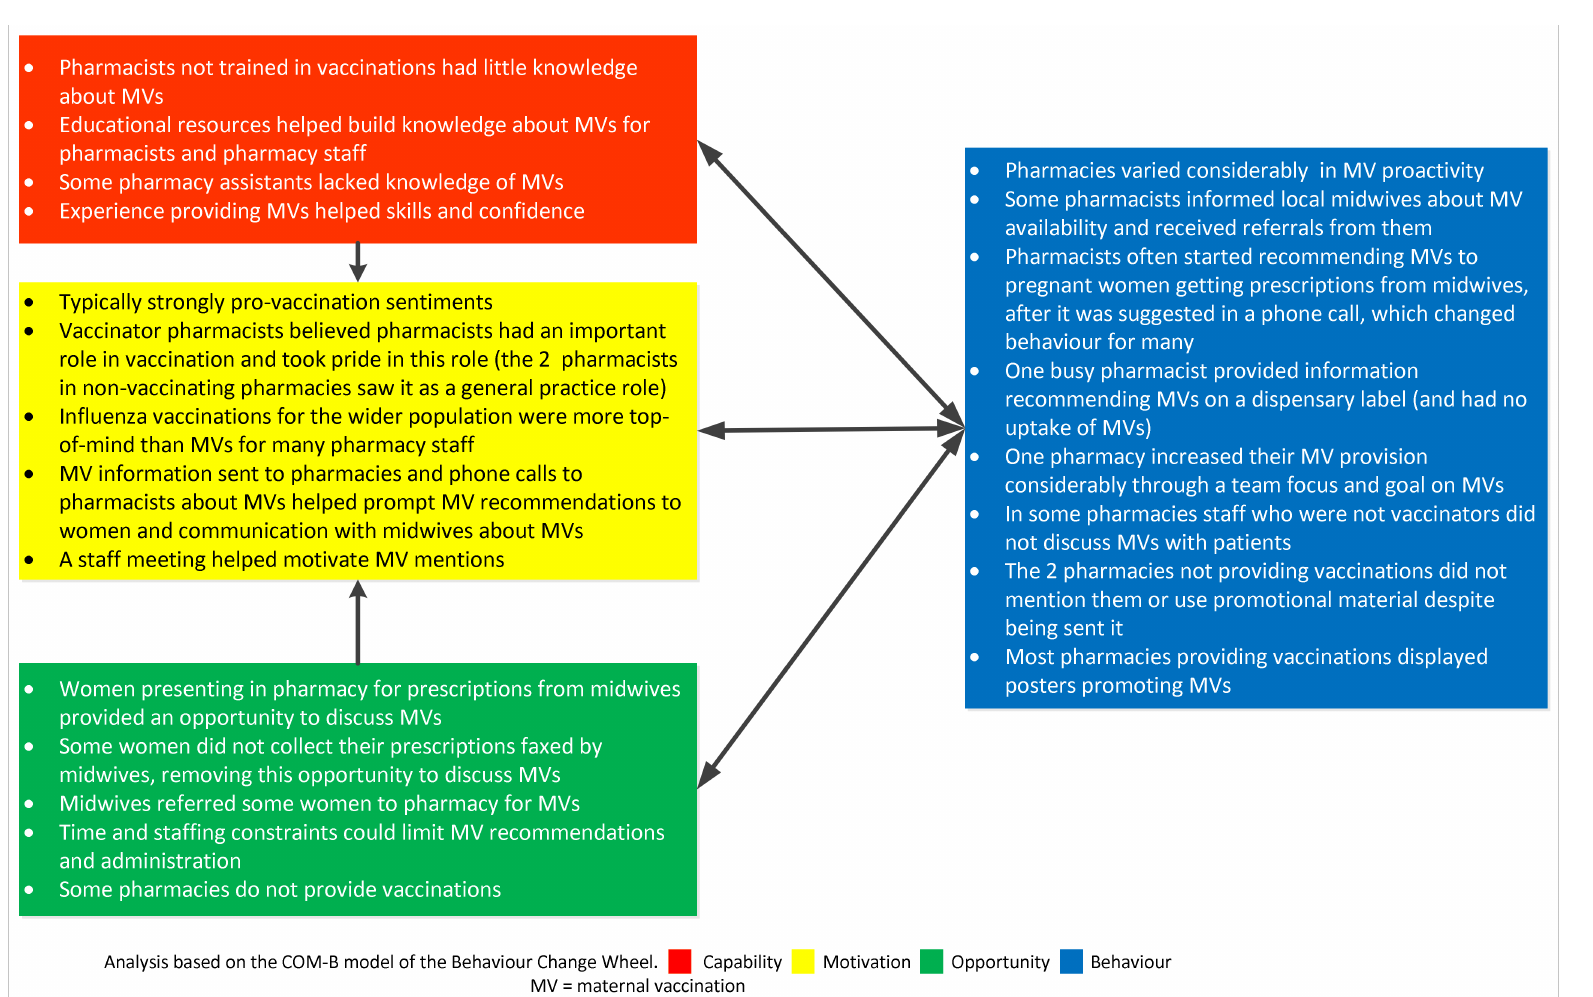
Figure 4. Factors affecting the recommendation and administration of maternal vaccines (MVs) for pharmacists using the COM-B